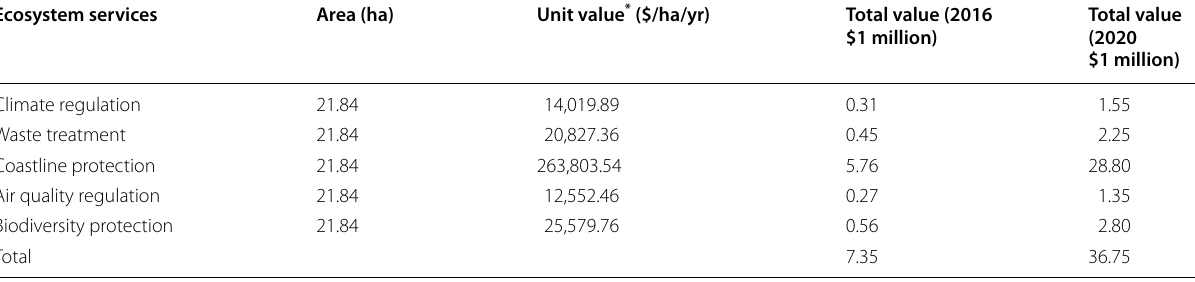
*Represents the mean value of each ecosystem service of mangroves in the Fujian Province, China